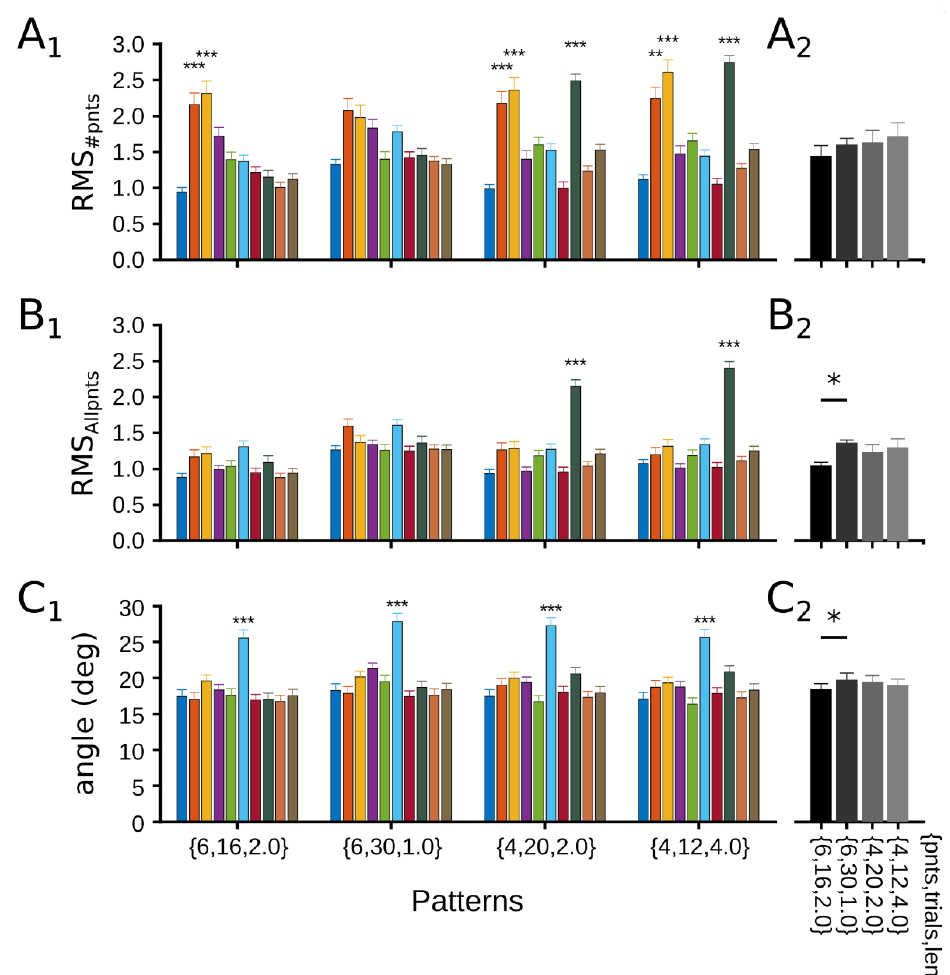
Figure 7. Performance of the four best patterns. ( 1 ) Average errors of patterns across scales. ( 2 ) Mean errors for each pattern as scale outputs are averaged in a single value. Bars show the average errors for RMS #points ( A ), RMS Allpnts ( B ), and angle difference between vectors ( C ) across scales ( 1 ) or mean errors ( 2 ). * p < 0.05; ** p < 0.01; *** p < 0.001. Statistical comparisons for figures in 1 are not shown.